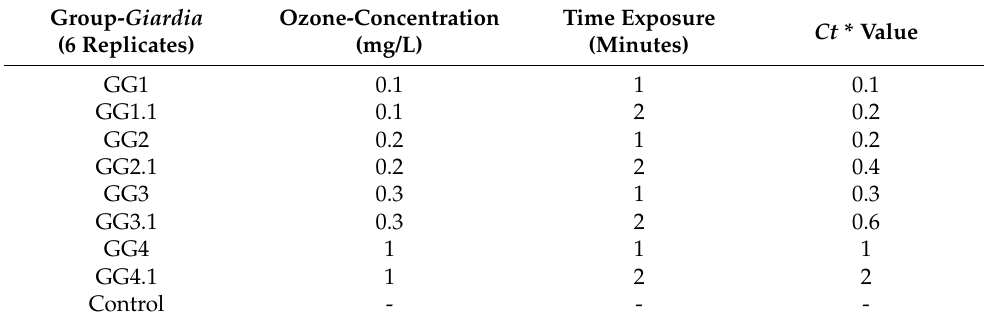
Table 2. In vitro tests for Giardia oocysts using different ozone concentrations and time exposure (minutes) in the